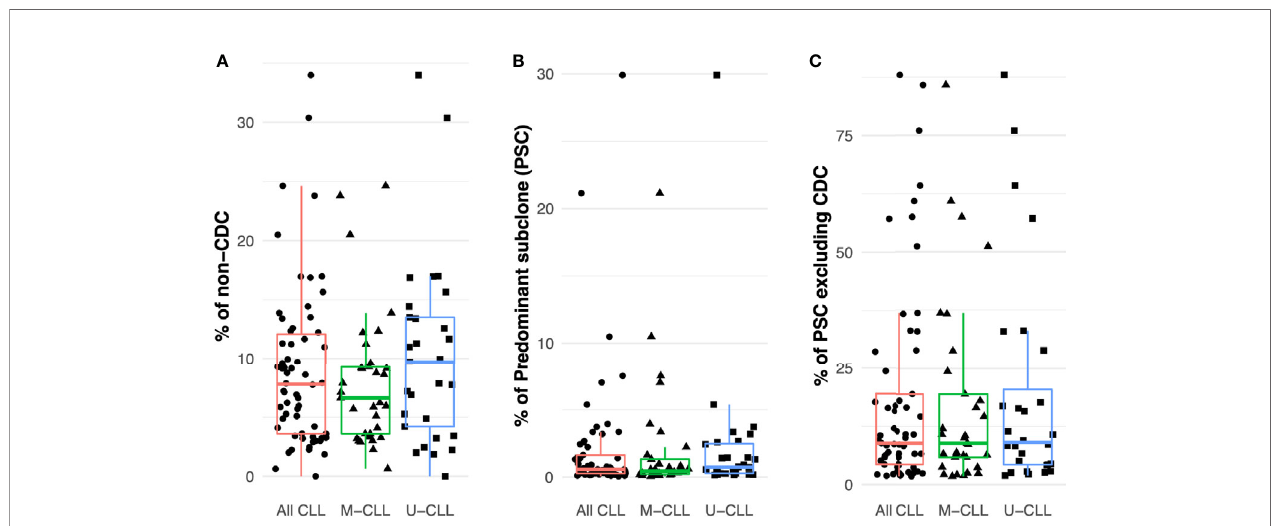
FIGURE 2 | Intraclonal IGHV-D-J diversity is relatively common in CLL. (A) Fraction of the intraclonal IGHV-D-J variant sequences among the total number of mRNA molecules coding the CLL clonal family in the 61 patients examined. (B) Frequency of PSCs among the total number of mRNA molecules encoding the CLL clonal family. (C) Fraction of the subclonal IGHV-D-J variants that the PSCs represent after excluding the CDC